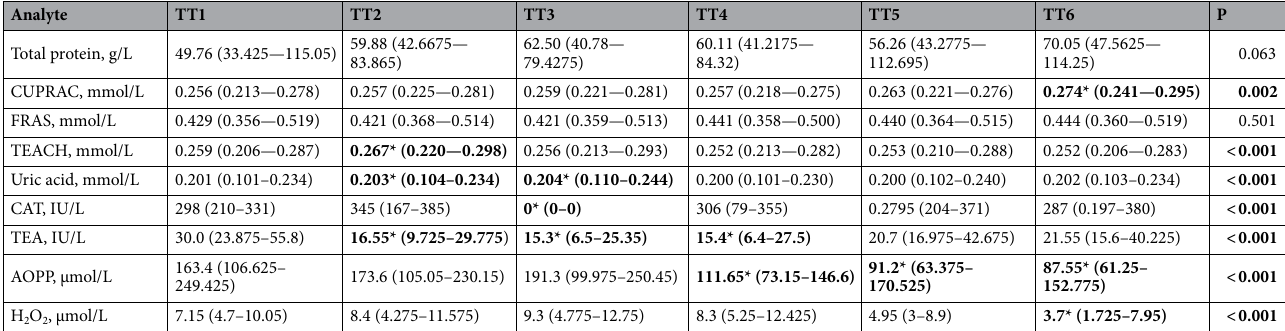
Table 1. Effect of inactivation protocols in salivary total protein and oxidative status biomarkers [median (25–75 percentile)]. Significant values are in bold. *P < 0.05. Control (TT1); 65 °C 30 min (TT2); 92 °C 15 min